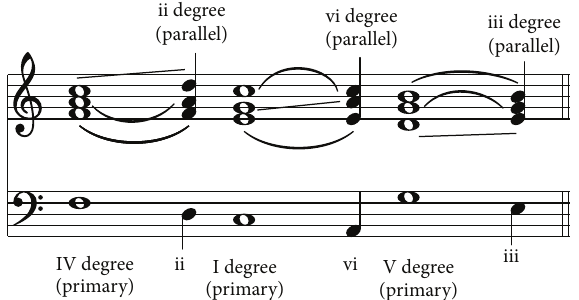
Figure 4: Table of the six primary and parallel chords in the key of C major used in the Harmonic Walk application. The common notes between a primary and its parallel chord are tied, while the changing notes are linked with a straight line.